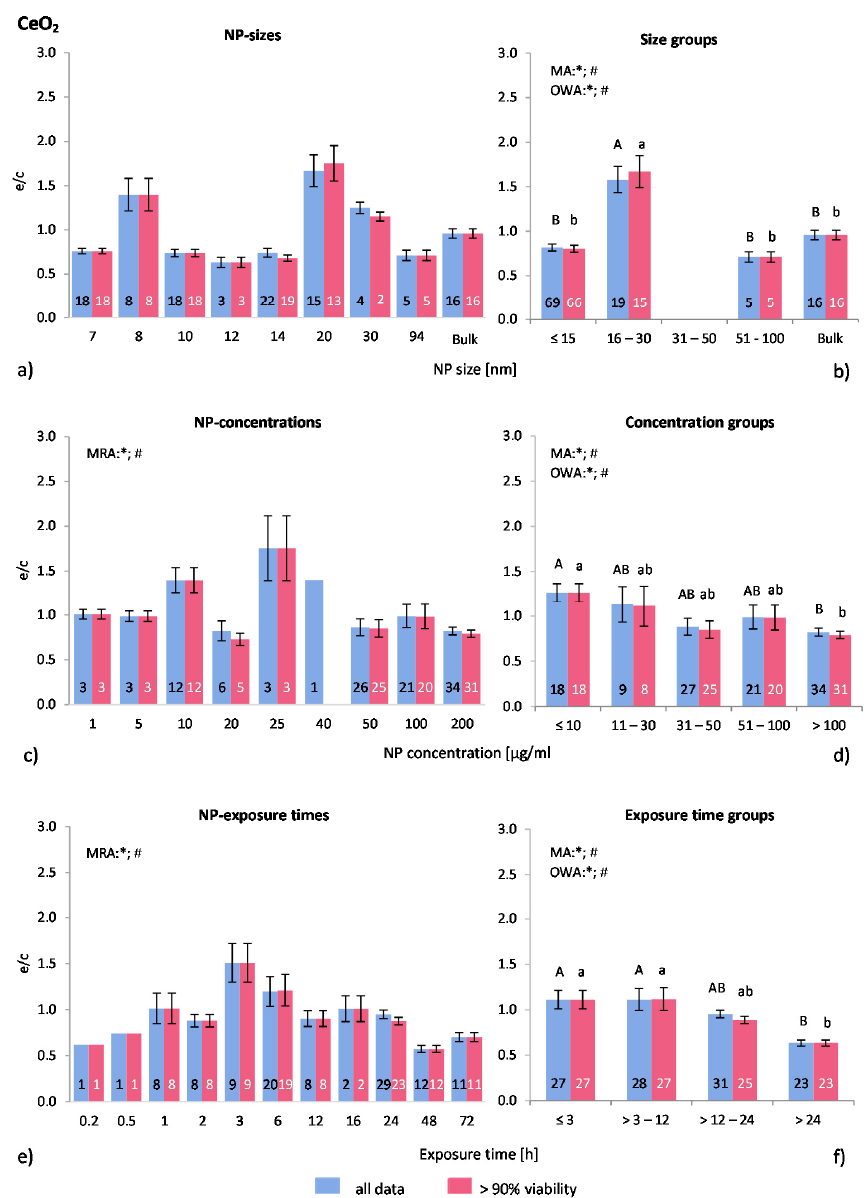
Figure 7. The effect of NP-size, concentration and exposure time on ROS ratios after exposure to CeO 2 -NP. Data are illustrated as mean ± SEM and numbers inside the bars represent the number of investigations. Mean ROS ratios as a function of ( a ) NP-size, ( c ) NP-concentration and ( e ) exposure times are shown. Multiple Regression Analysis (MRA) was used to identify correlations between the independent variables NP size, concentration or exposure time and the dependent variable ROS ratio; ( b , d , f ) show the respective groupings that were analyzed with multi-factor ANOVA (MA) for statistical significant inhomogeneity for three variables, one-way ANOVA (OWA) for one variable, and the modified post-hoc Tukey test for unequal n for group differences. The bars labelled “a” or “A” etc. are statistically different from “b” or “B” but not from “ab” or” AB”. p < 0.05 for * all data and # for >90% viability.